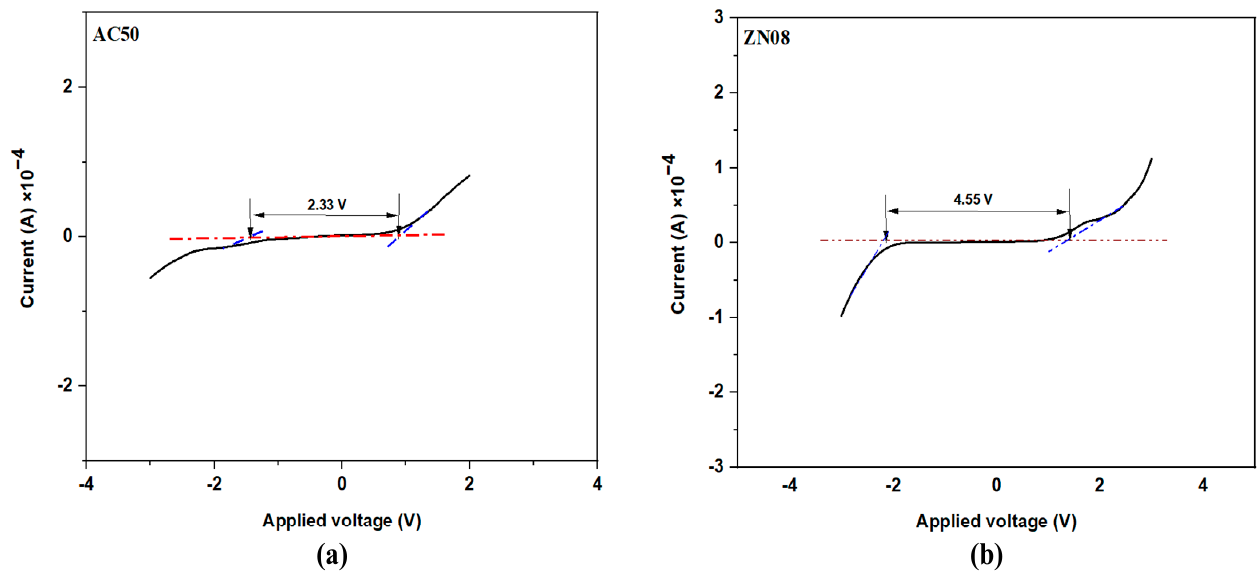
Figure 9. LSV plots of SPE and NCSPE ( a ) AC50 ( b ) ZN08. Table 5. Comparison of selected SPEs based on electrochemical potential window. Host